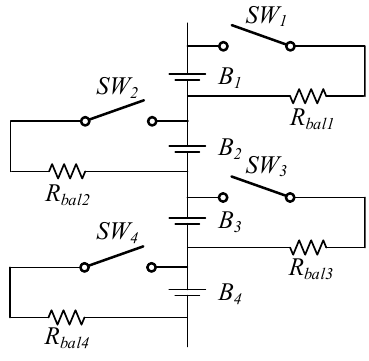
Figure 1. Passive balancing method.